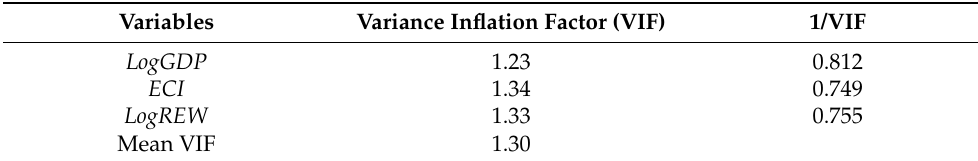
Table 5. Multicollinearity Test considered OLS estimator.